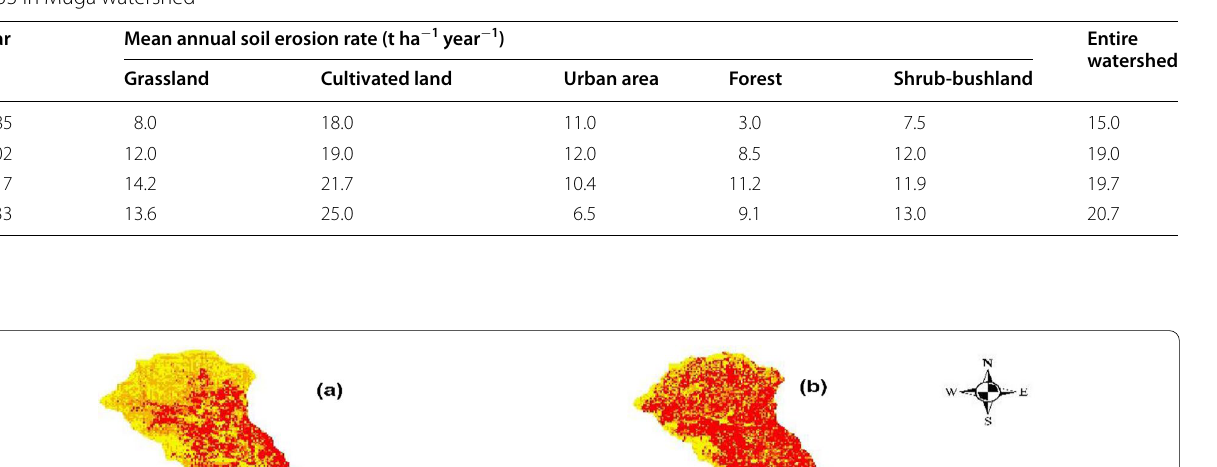
Table 8 Estimated mean annual soil erosion rate of each land use land cover type and the entire watershed in 1985, 2002, 2017, and